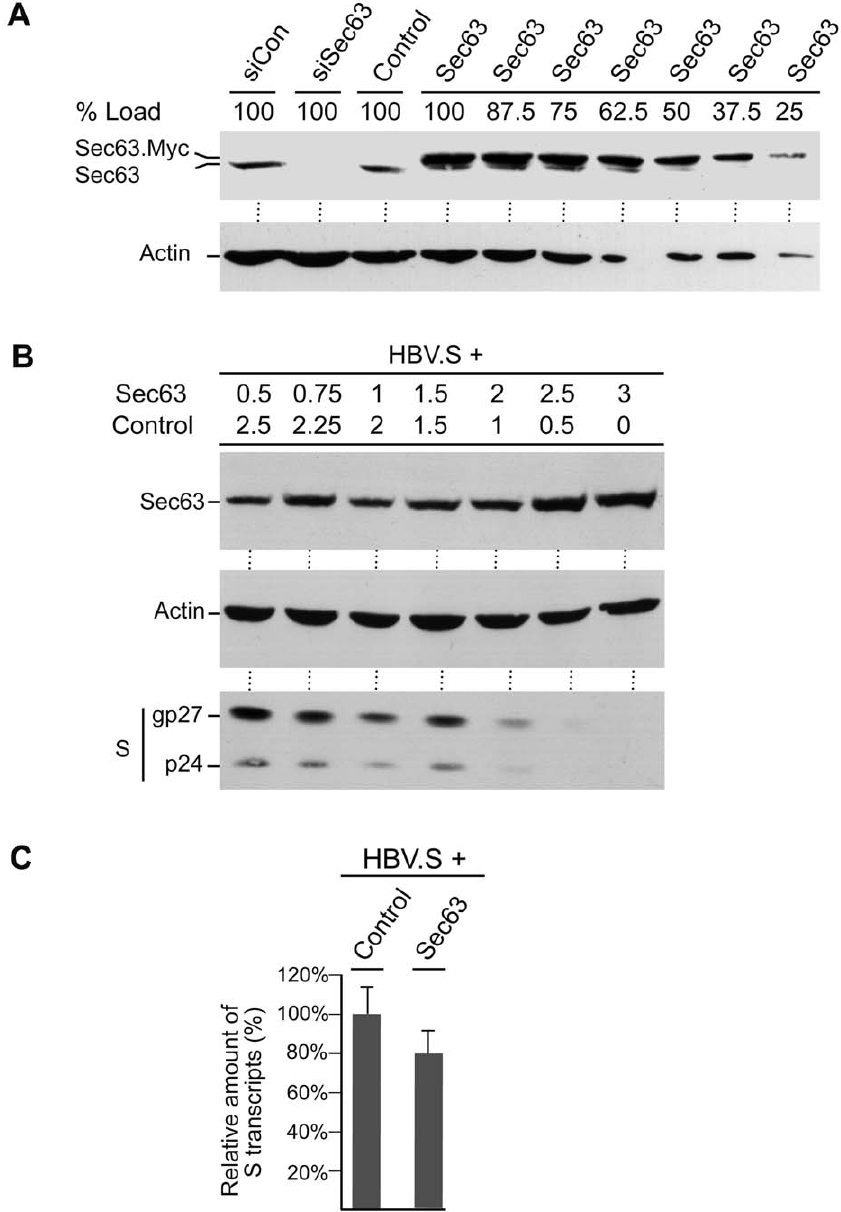
Figure 2. Overexpressing of Sec63 reduces the steady-state HBV.S level in a dose-dependent manner without grossly affecting transcription. A. HuH-7 cells were either treated with control siRNA (siCon) or siRNA duplexes targeting Sec63 (siSec63) or were transfected with control DNA (Control) or Myc-tagged Sec63 (Sec63; 3 m g DNA). NP-40 cell lysates were prepared after three days and probed by anti-Sec63 WB. For calculation of the degree of Sec63 overexpression, the Sec63-transfected lysate was serially diluted prior to gel loading as indicated above the lanes (% Load). B. Cells were transfected with HBV.S (1 m g DNA) together with increasing amounts of Sec63 DNA, as indicated above the lanes (in m g). Total DNA used for transfections was adjusted with empty plasmid DNA (Control). Extracts were prepared with SDS lysis buffer two days after transfection and assayed by Myc- (top), b -actin- (middle), and HA-specific (bottom) WB. C. Cells were cotransfected with HBV.S and control or Sec63 plasmids as in Fig. 1B. HBV.S-specific transcripts were measured by quantitative reverse transcription PCR and are demonstrated in percent amount relative to control cells. Transfections and PCR runs were performed in duplicate, and error bars are standard error of the mean. doi:10.1371/journal.pone.0049243.g002 In yeast, Sec63p and its Kar2p partner protein have been were treated with the proteasome inhibitor epoxomicin. The efficacy of the drug during the applied assay conditions was indicated to be involved in the export of misfolded proteins to the cytosol during ER-associated degradation (ERAD) by the protea- indicated by the appearance of C-terminally degraded Sec63 some [30,31]. For the mammalian Sec63, such a role is ill-defined. derivatives that accumulated in epoxomicin- but not in mock- To examine whether the up-regulation of Sec63 reduced the treated cells (Fig. 4B). Importantly, the inhibition of the ERAD pathway did not abolish the ability of excess Sec63 to down- HBV.S level via an enforced export out of the ER, transfected cells